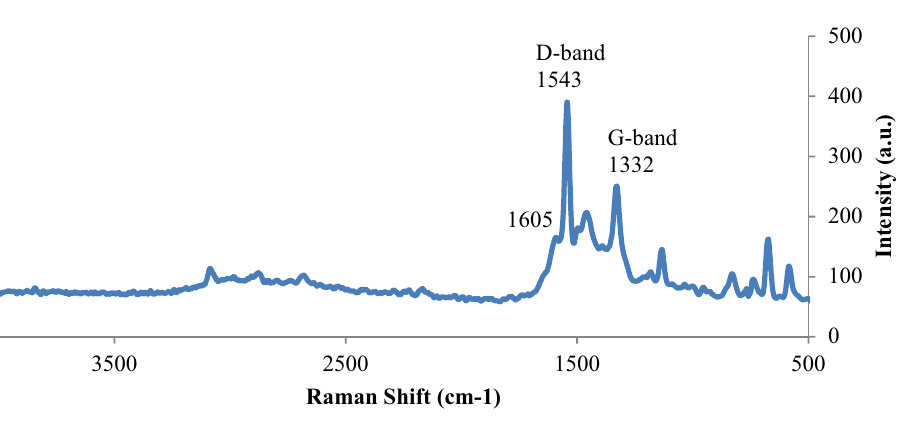
Figure 3. Raman spectrum of NiPc@GO.